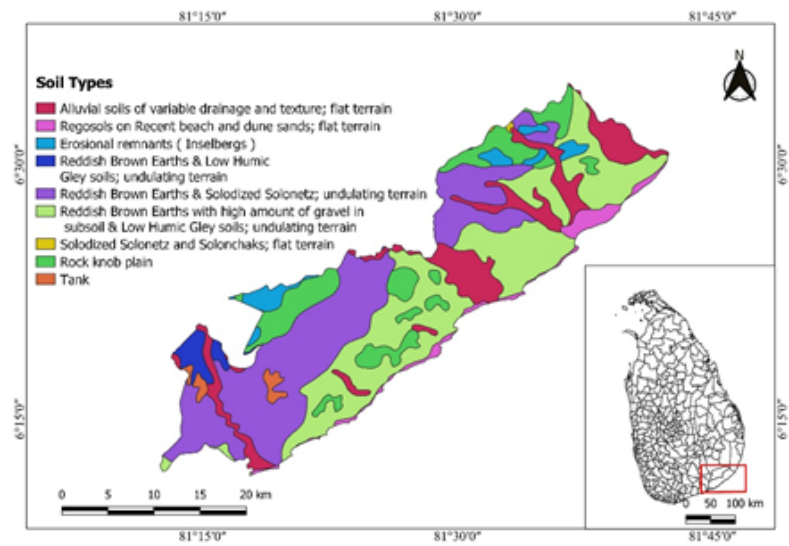
Figure 2. Soil type distribution in Tissamaharama DSD.